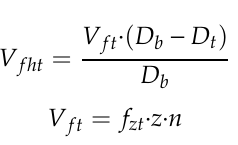
Figure 2. Tangential and peripheral speed.